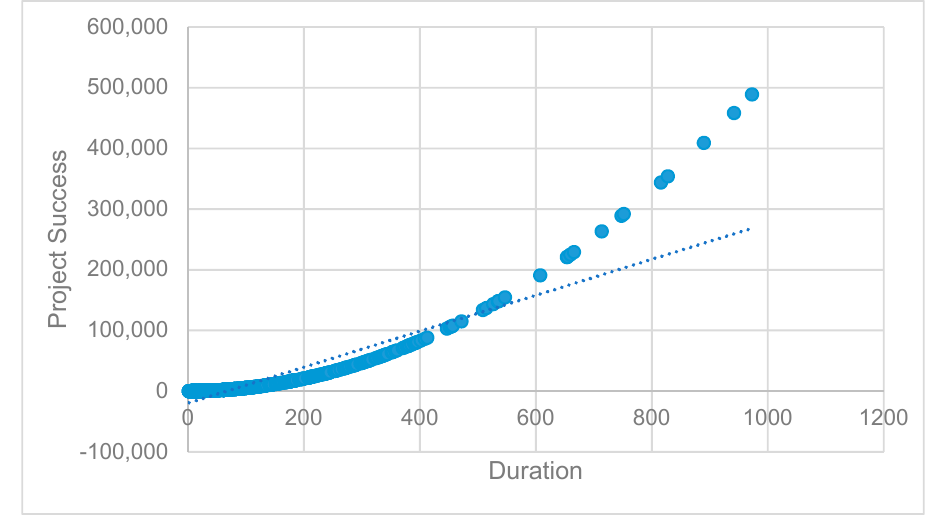
Figure 3. The non-linear effect of duration on project success.